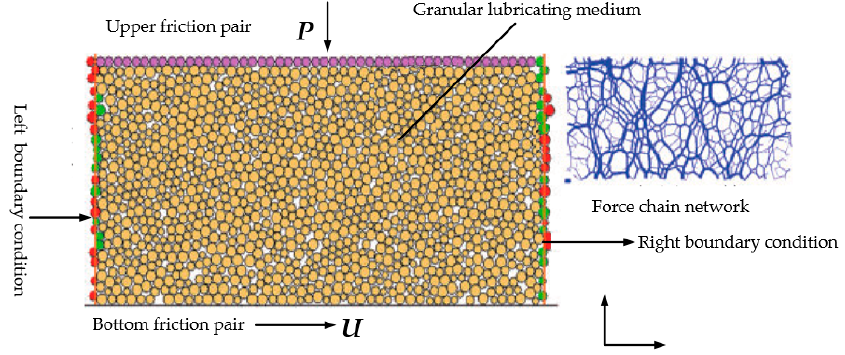
Figure 17. Discrete element model for particle flow lubrication (Adapted from [169]).